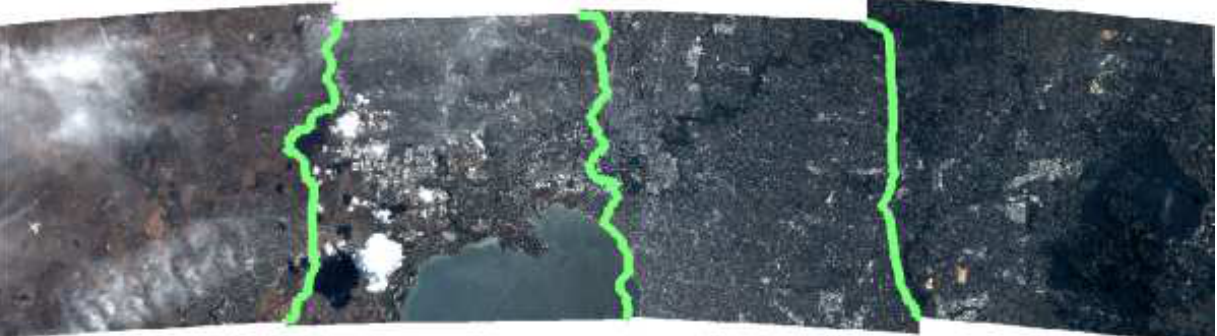
Figure 4. Pleiades’ 4 strips mosaic of Melbourne with stiching line ©CNES Copyright